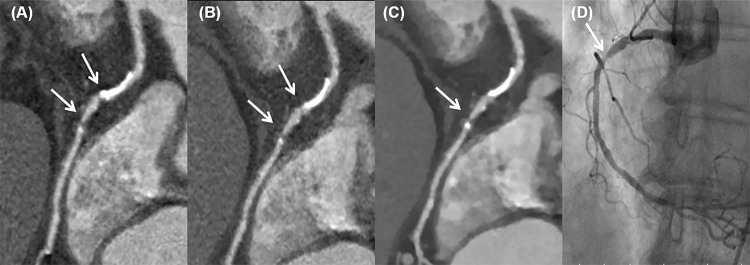
A 48-year-old female with high calcium score, of greater than 800.Curved MPR reformatted RCA with filter back projection image (A) and iDose4 image (B) shows two significant obstructive lesions are seeen at mid RCA (arrows). However, IMR image (C) shows that the lesion in the proximal portion with clacification was a false lesion due to blooming artifact and only the lesion in the distal portion was a significant obstructive lesion. Invasive coronary angioraphy (D) confirmed the presence of one lesion as shown in the IMR image.